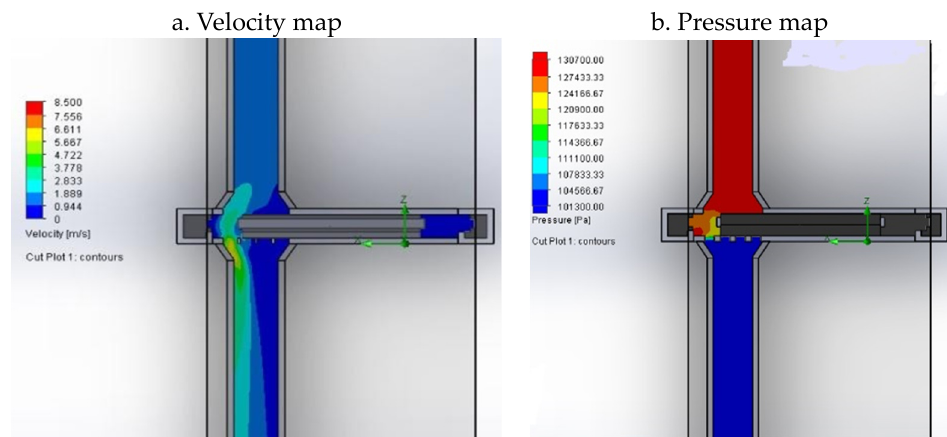
Figure 17. Third valve geometry with 10% opening.